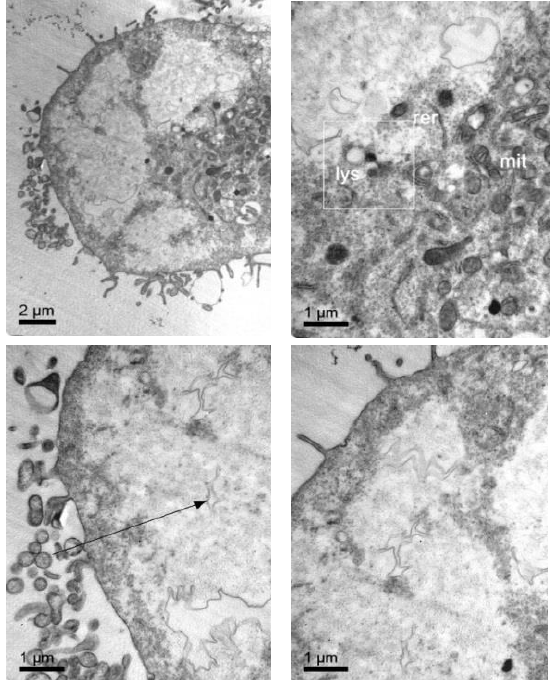
Figure 7. TEM images illustrating elosulfase alfa-loaded NLC internalized into TC28a2 chondrocytes during co-incubation.